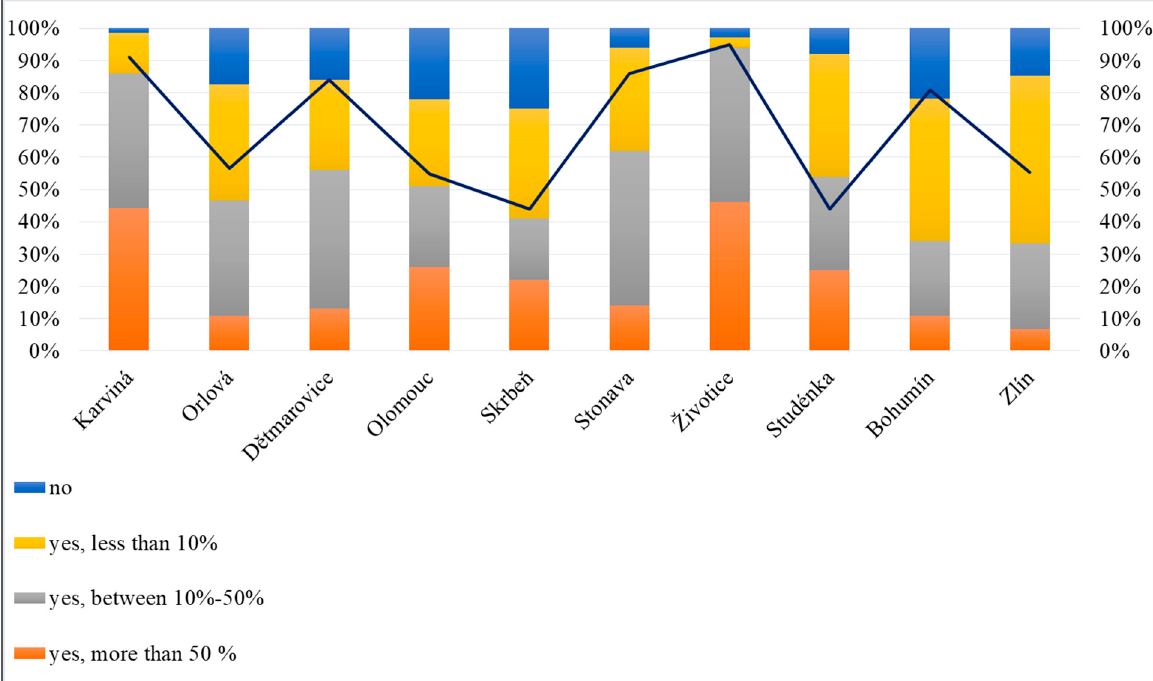
Figure 3. Respondents’ attitudes to the influence of brownfields on the price of neighbouring real estate. Source: own survey (n = 1,152).